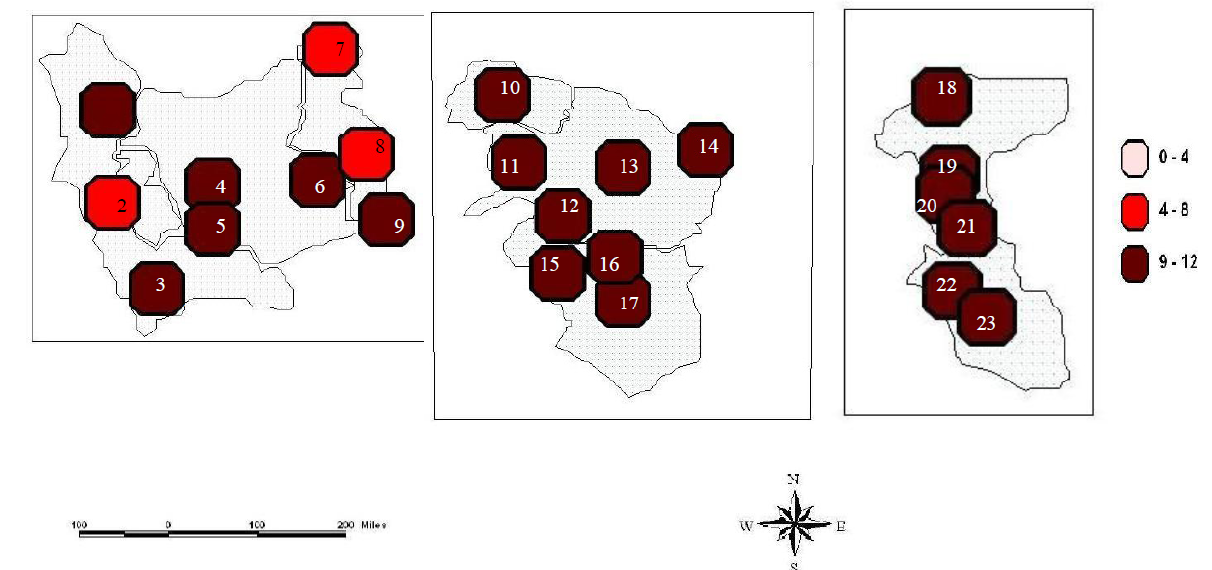
Fig. 4. Location rating based on Sunshine hour. 1-Kooy; 2-Oroomieh; 3-Mahabad; 4-Tabriz; 5-Maragheh; 6-Sarab; 7-Parsabad; 8-Ardebil; 9-Khalkhal; 10-Bojnurd; 11-Sabzevar; 12-Kashmar; 13-Mashhad; 14-Sarakhs; 15-Ghaen; 16-Ferdous; 17-Birjand; 18-Kashan; 19-Isfahan; 20-Shargh Isfahan; 21-Abadeh; 22-Shiraz;